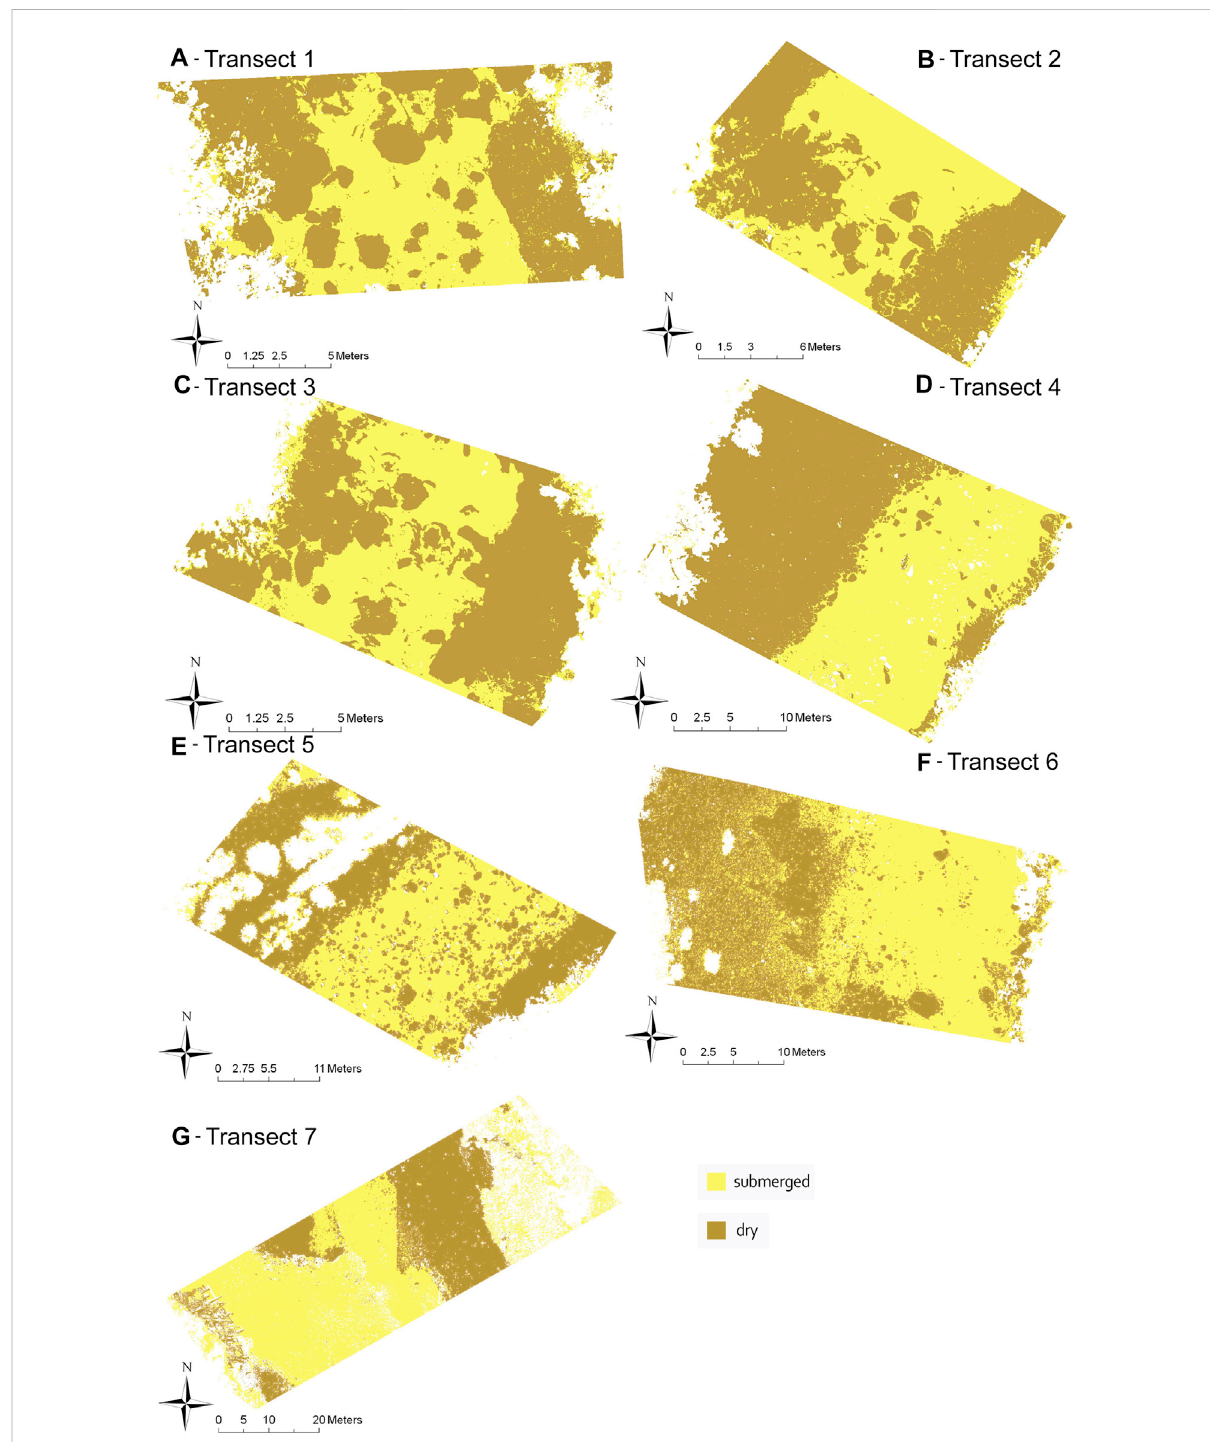
FIGURE 6 Classi fi ed orthomosaics for transects 1 – 7 (A – G) with RV removed using a simple supervised classi fi cation. Yellow is submerged substrate and brown is dry substrate.